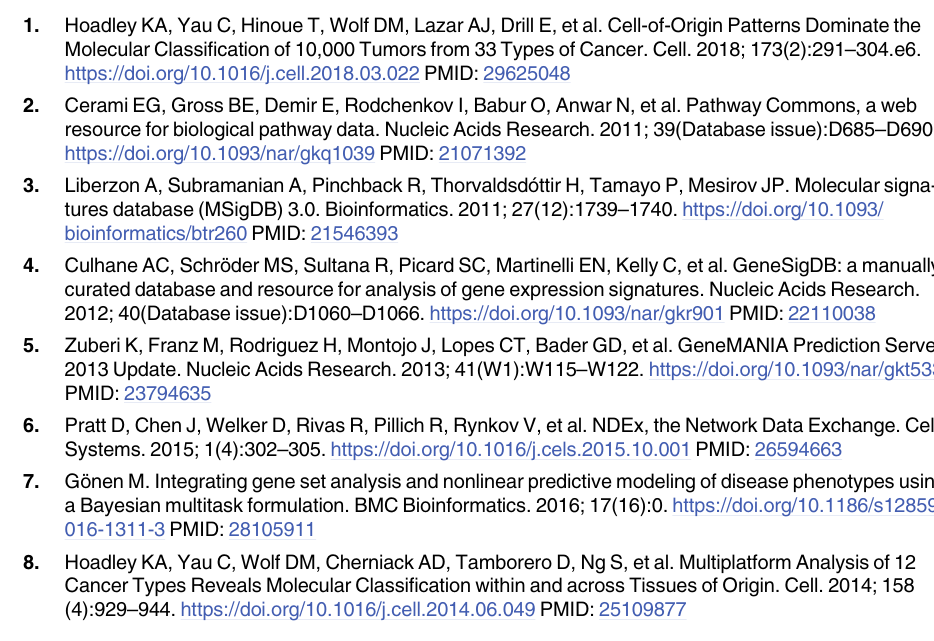
S13 Fig. Metrics for CTNNB1 AKLIMATE models with and without the use of mutational profiles for 8 key regulators. Results averaged over 10 matched stratified 80%/20% train/test splits.